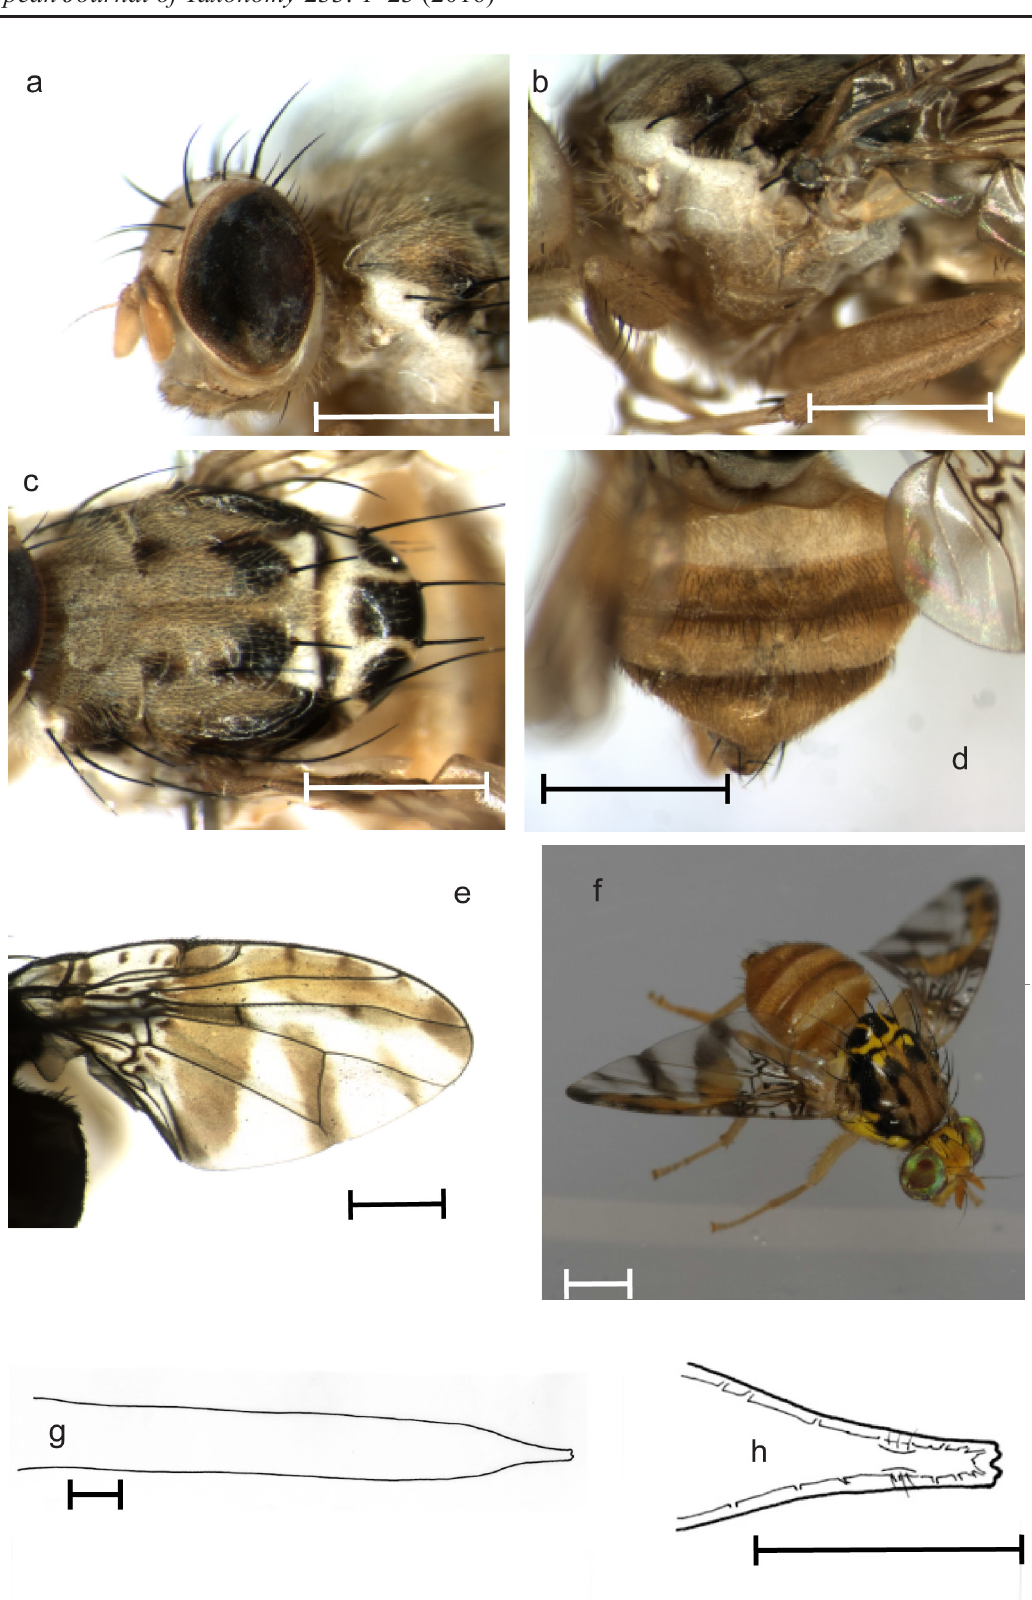
Fig. 4. Ceratitis sawahilensis De Meyer & Virgilio sp. nov. a . Head and thorax, anterodorsal view. b . thorax, lateral view. c . thorax, dorsal view. d . abdomen, dorsal view. e . wing. f . Habitus image (credit: S.a. Marshall). g . Female aculeus. h. aculeus tip. Scale bars: a–F = 1 mm; g–H = 0.1